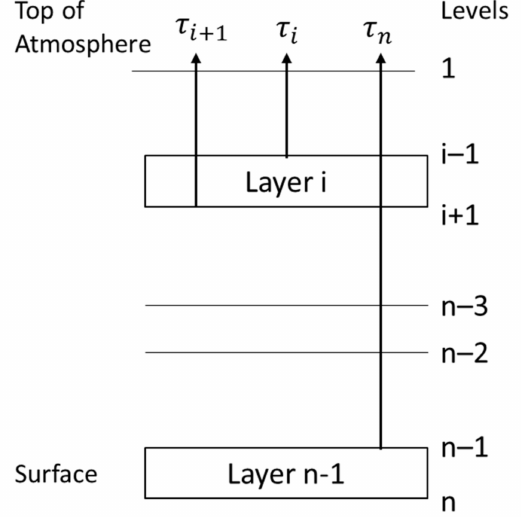
Figure 27. Line-by-line approach of atmospheric models for radiative transfer, considering atmo- spheric layers from the top of the atmosphere. Adapted from